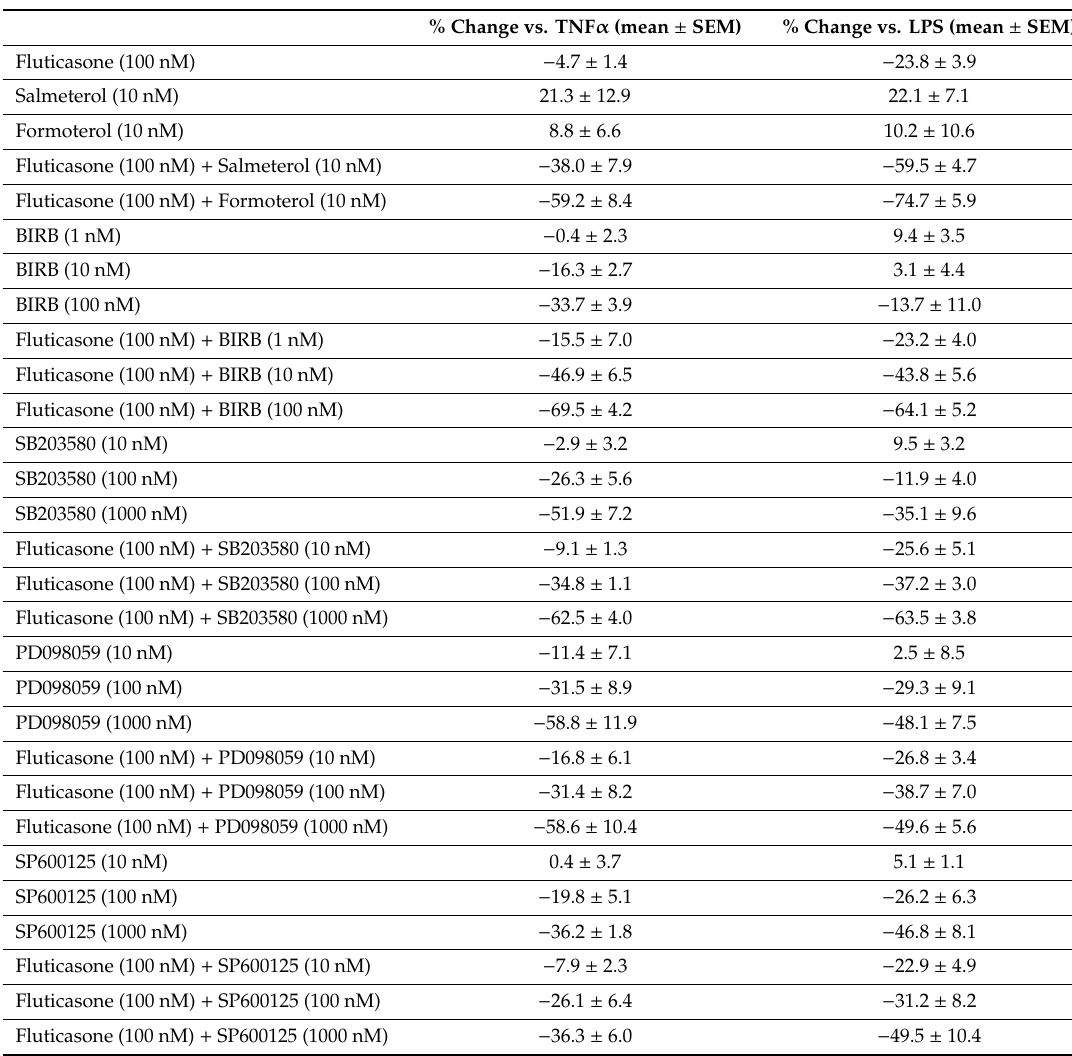
Table 1. E ff ects of drugs and combinations on IL-8 expressed as % change. Data from Figure 1; Figure 2 were re-analyzed by calculating the drug e ff ects on IL-8 as % change vs. stimulation with TNF α or LPS alone (each plus DMSO solvent control). Negative values show an inhibitory e ff ect of the drug. % Change vs. TNF α (mean ±